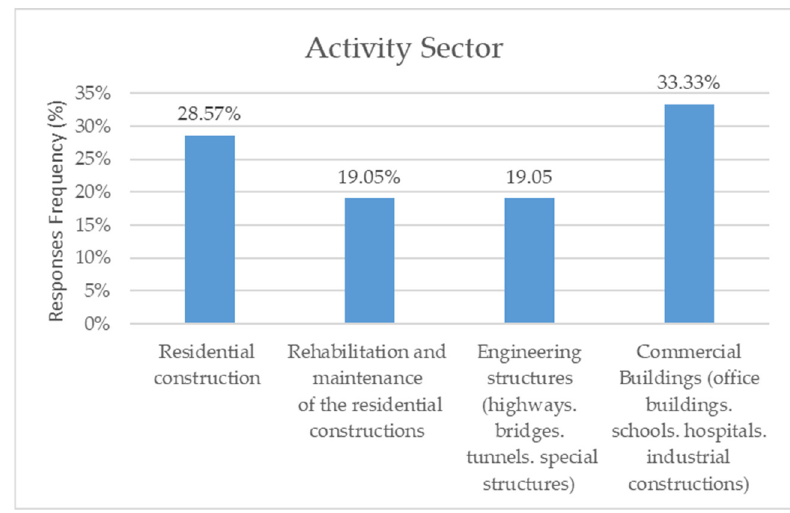
Figure 3. Activity sector of the respondents.